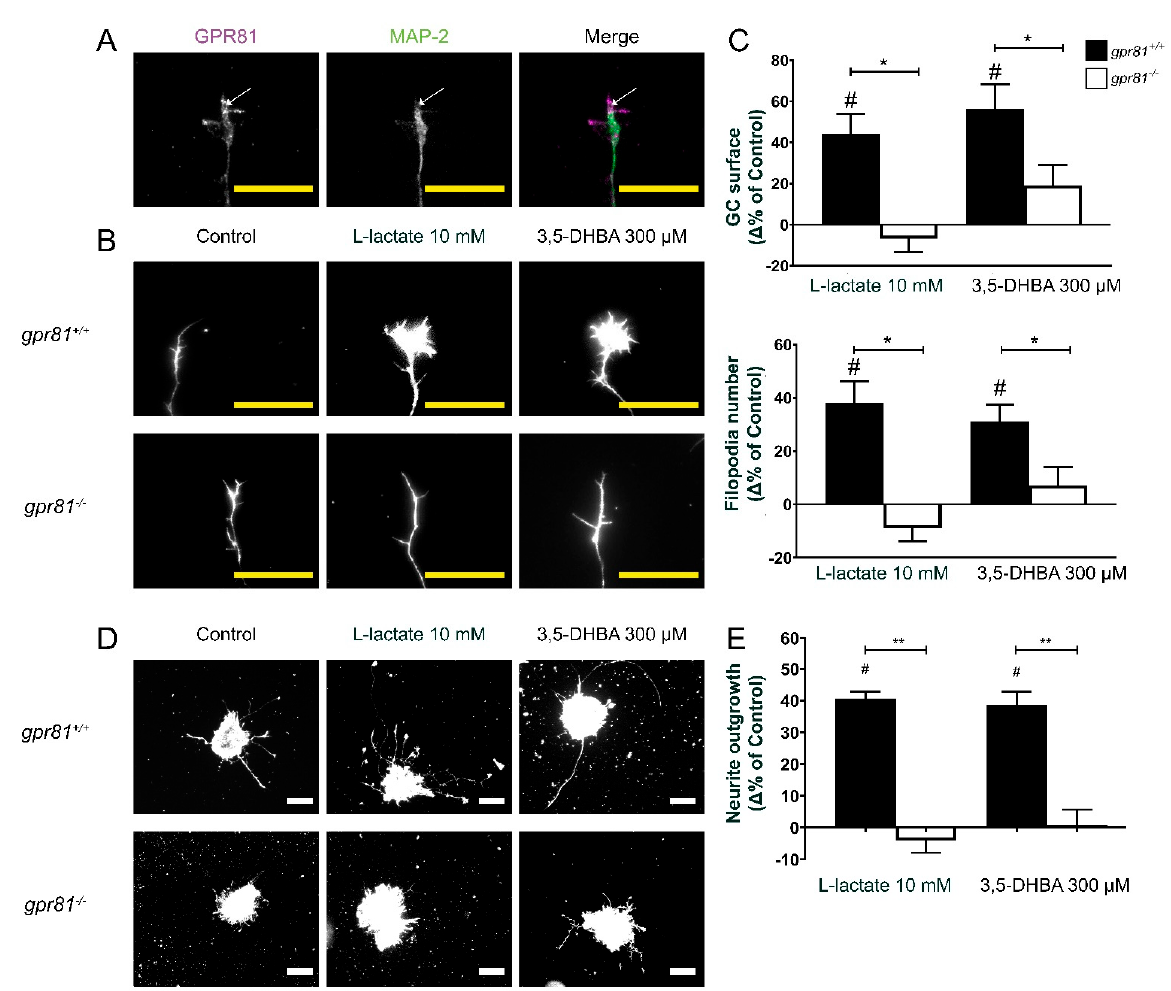
Figure 2. L-lactate and 3-5-DHBA influence GC dynamics and increase axon growth via GPR81 agonism. ( A ) GPR81 is expressed in GCs in vitro. ( B ) Microscopic photography of GCs following 1 h treatment with GPR81 agonists. Explants were marked with phalloidin conjugated with Alexa fluor 546. ( C ) Analysis of GC surface area and filopodia number ( n = 48–147 GCs per condition). Values are presented as the means ± SEM. ( D ) Microscopic photography of retinal explants following 15 h treatment with the GPR81 agonists. Explants were marked with phalloidin conjugated with Alexa fluor 546. ( E ) Analysis of RGC axon projections ( n = 278–2572 axons per condition). Values are presented as the means ± SEM. # Indicates significant changes compared to the control group. * Indicates significant changes p < 0.05 between gpr81 +/+ and gpr81 − / − genotype. ** Indicates significant changes p < 0.01 between gpr81 +/+ and gpr81 − / − genotype. Statistical test used is the Krustal–Wallis nonparametric ANOVA. White scale bar: 100 μ m. Yellow scale bar 25 μ m.